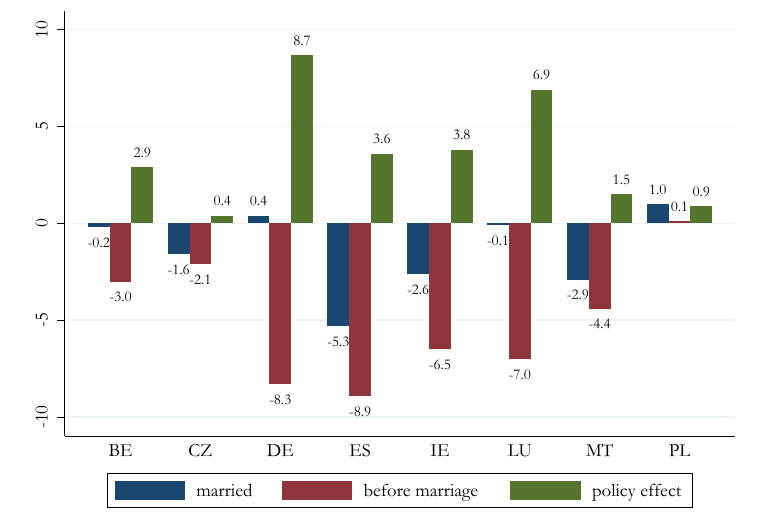
Figure 2. The gender gap in METR before and after marriage. Notes: EUROMOD estimations for 2019 based on EU-SILC 2019. Before marriage refers to the scenario where married couples are treated as cohabitants by tax-benefit